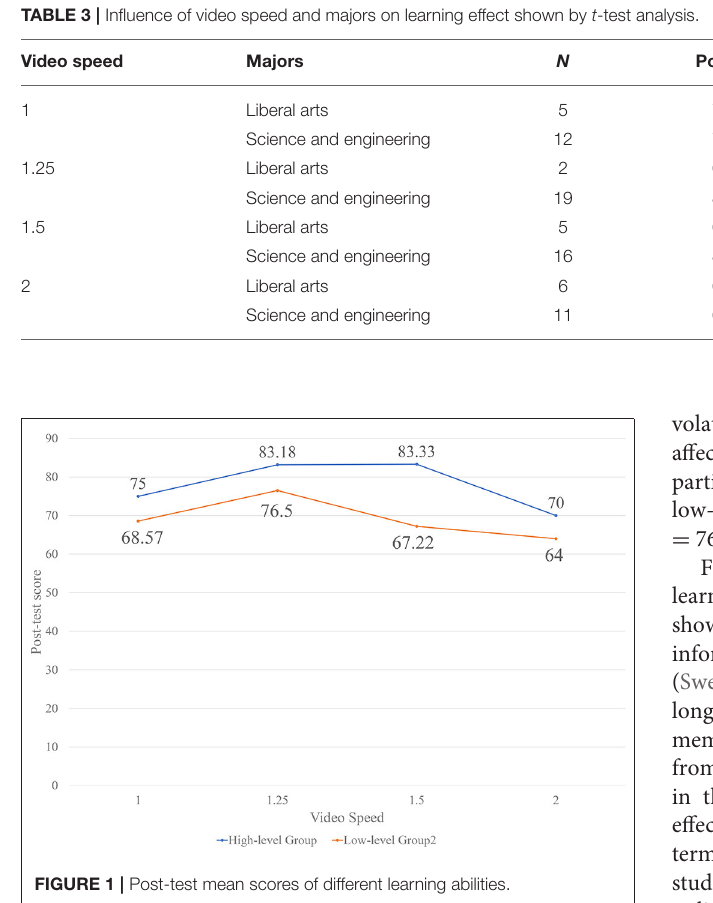
show little difference between the participants majoring in liberal arts and